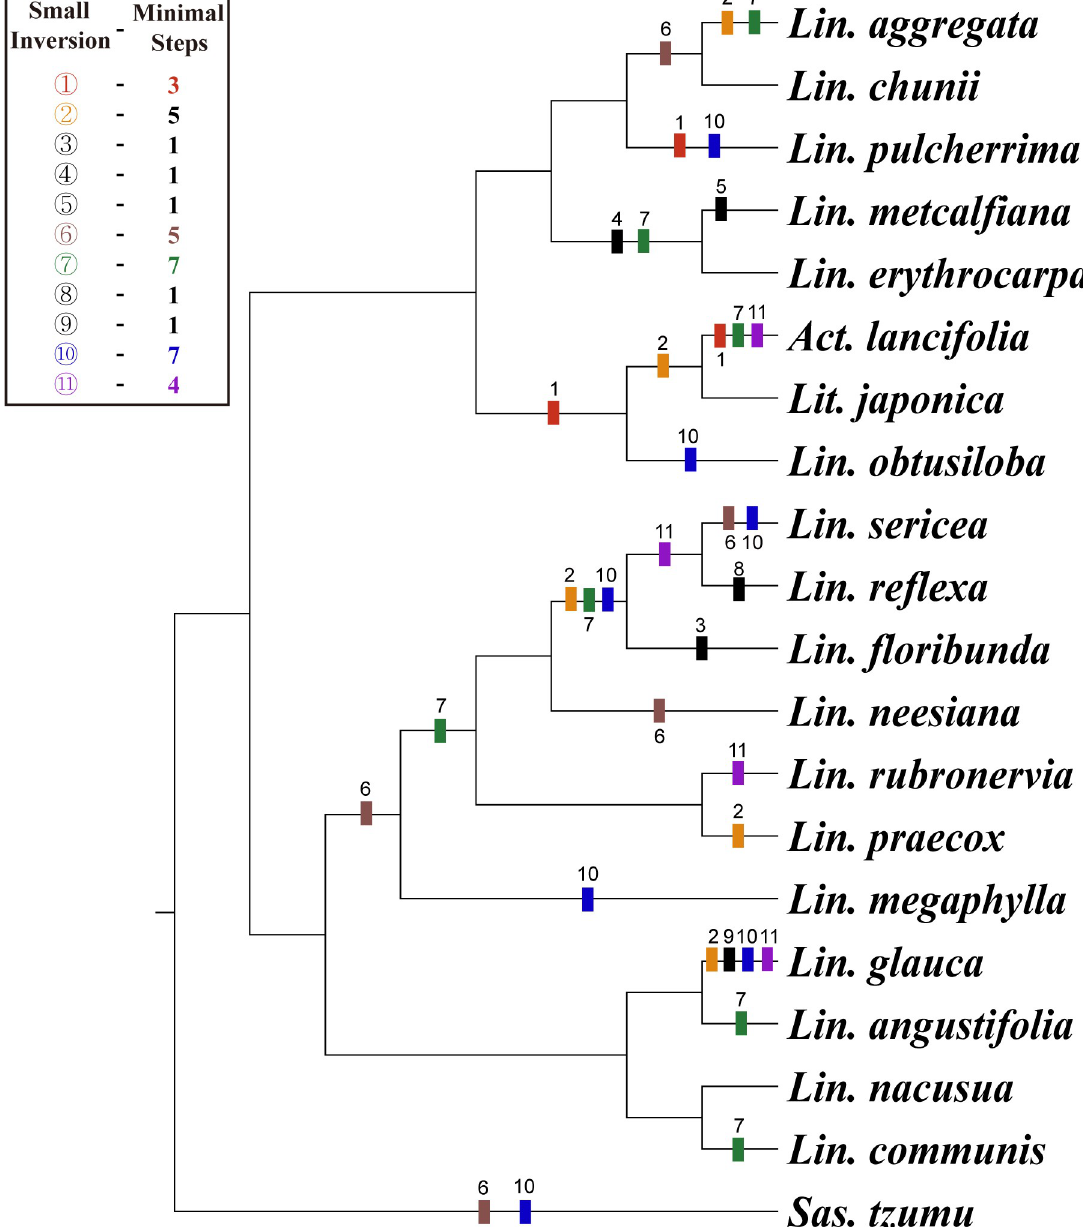
Fig 3. The evolutionary changes of 11 small inversions. The changes of each small inverion was plotted by ACCTRAN character transformation criteria of parsimony analysis on the Maximum likelihood (ML) tree for 20 Lauraceae based on whole plastome sequences. The aligned sequence was 156,569 bp in length. The ML tree was determined by RAxML with -ln L = 259398.416970. The number above colored bar indicates the change from A to B form and the number below colored bar indicates the changes from B to A form. The A form configurations of 11 SIs are given in Fig 2 and the B form structures are opposite direction to the arrow on the loop of A form. Detailed A and B form sequences and distribution among species are given in Table 3.